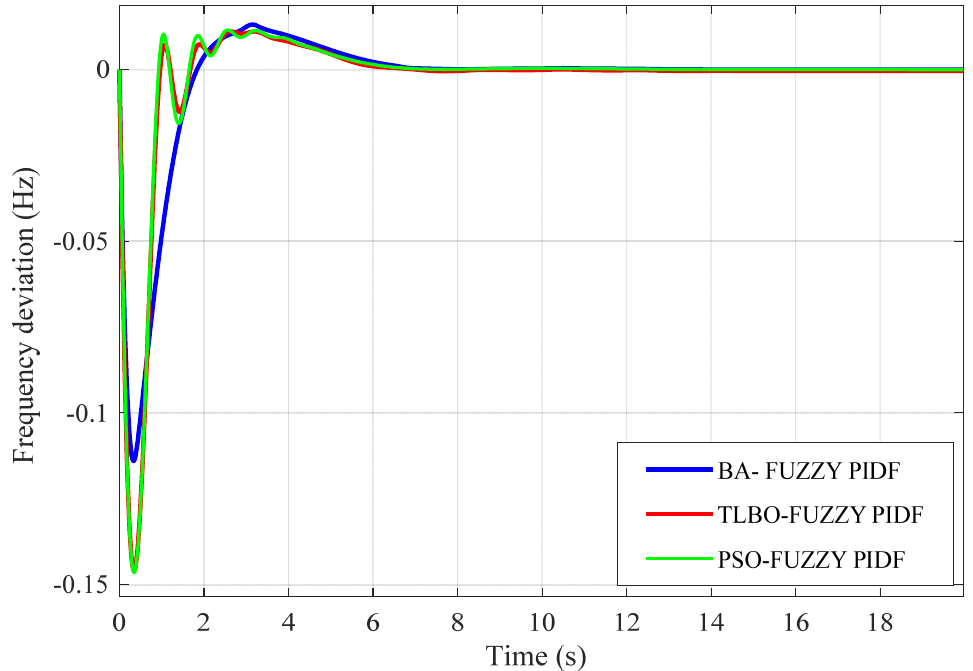
∆ F 1 ) under parametric uncertainties.